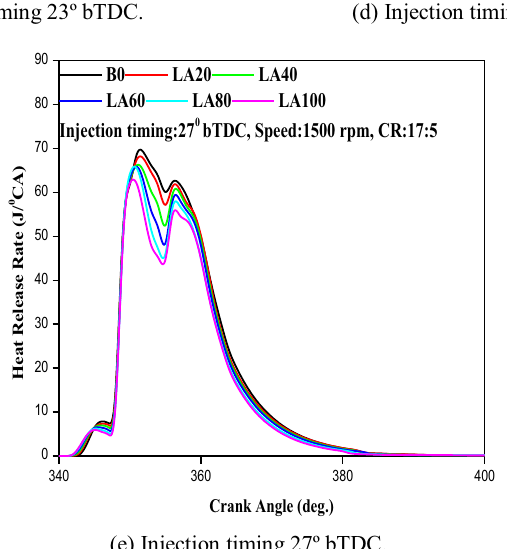
Figure 8. ( a–e ) The variation in HRR with different injection timing and engine load for blend